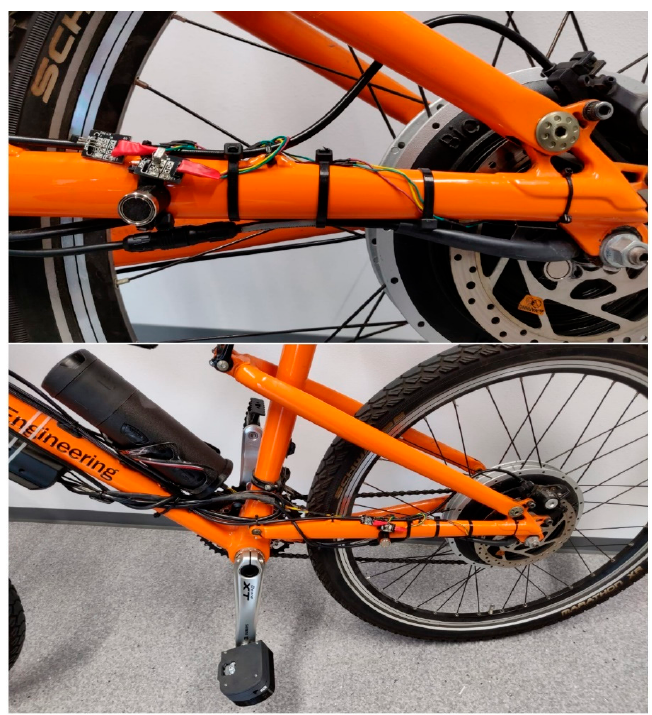
Figure 17. Final form of the Connected Bike